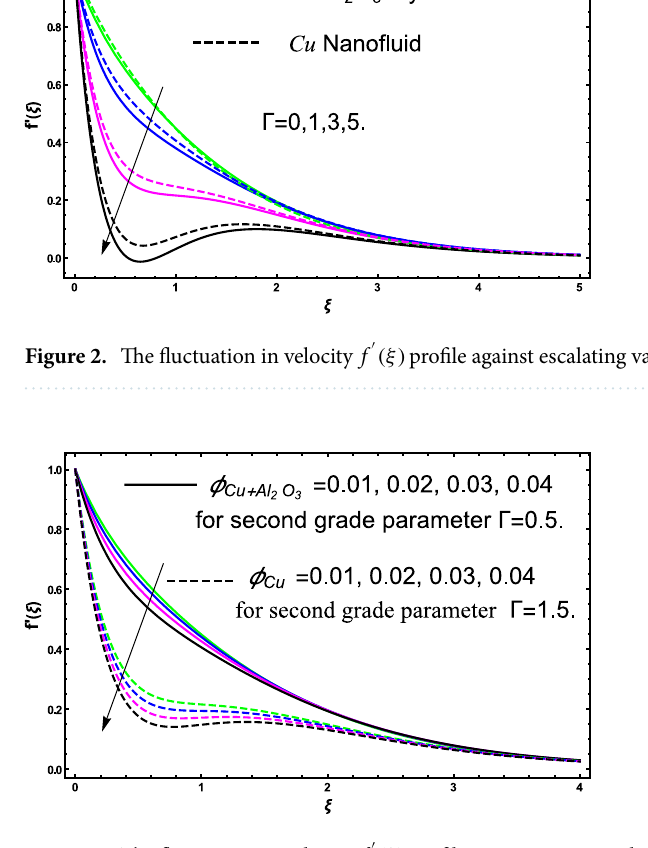
′ (ξ) profile against various values of φ Al 2 O 3 + Cu and φ Cu for elevated